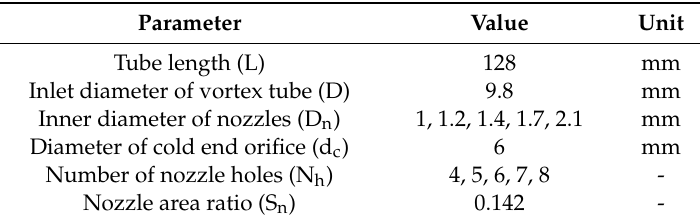
Table 1. Dimension of the vortex